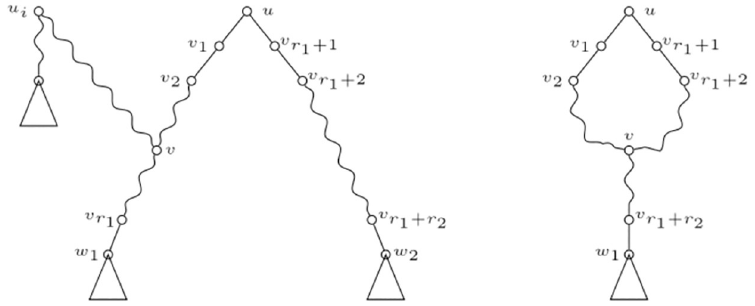
Fig 5. Strong paths from a tree node. A tree node u and its strong descendants w 1 and w 2 (left) or w 1 (right). The curly paths represent strong paths. The nodes v and u i are used in the proof of Lemma 16.